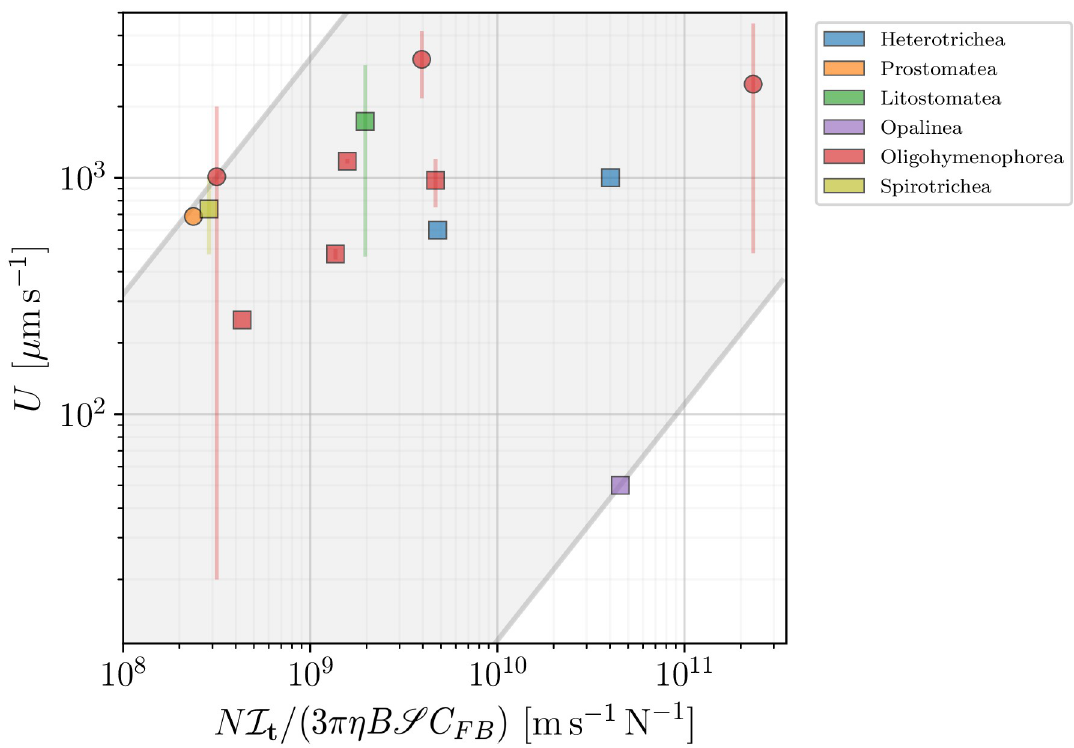
Fig 22. Reported swimming speed U plotted against the numerical prefactor of Eq (42), assuming a constant effective force per cilium in the propulsion model (B). Square symbols mark organisms for which the prediction was directly calculated from the available data, while circles represent those for which we estimated the number N of cilia. Colours distinguish the different taxonomic classes. The visible large scatter of data sets the bounds for the effective force per cilium to be in the range of 1.10 10 − 3 to 3.19 pN, represented by the shaded area in grey.